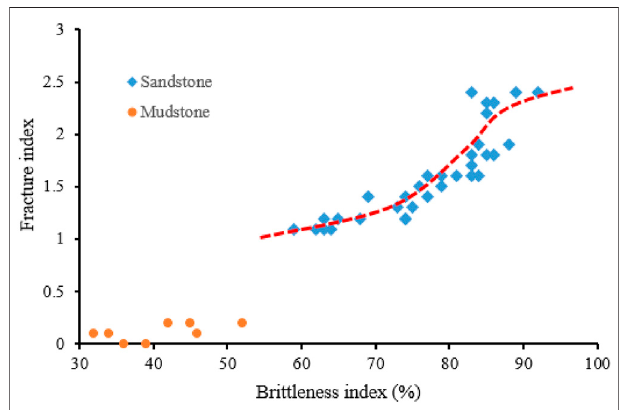
FIGURE 12 | Relationship between fracture index FI and rock brittleness